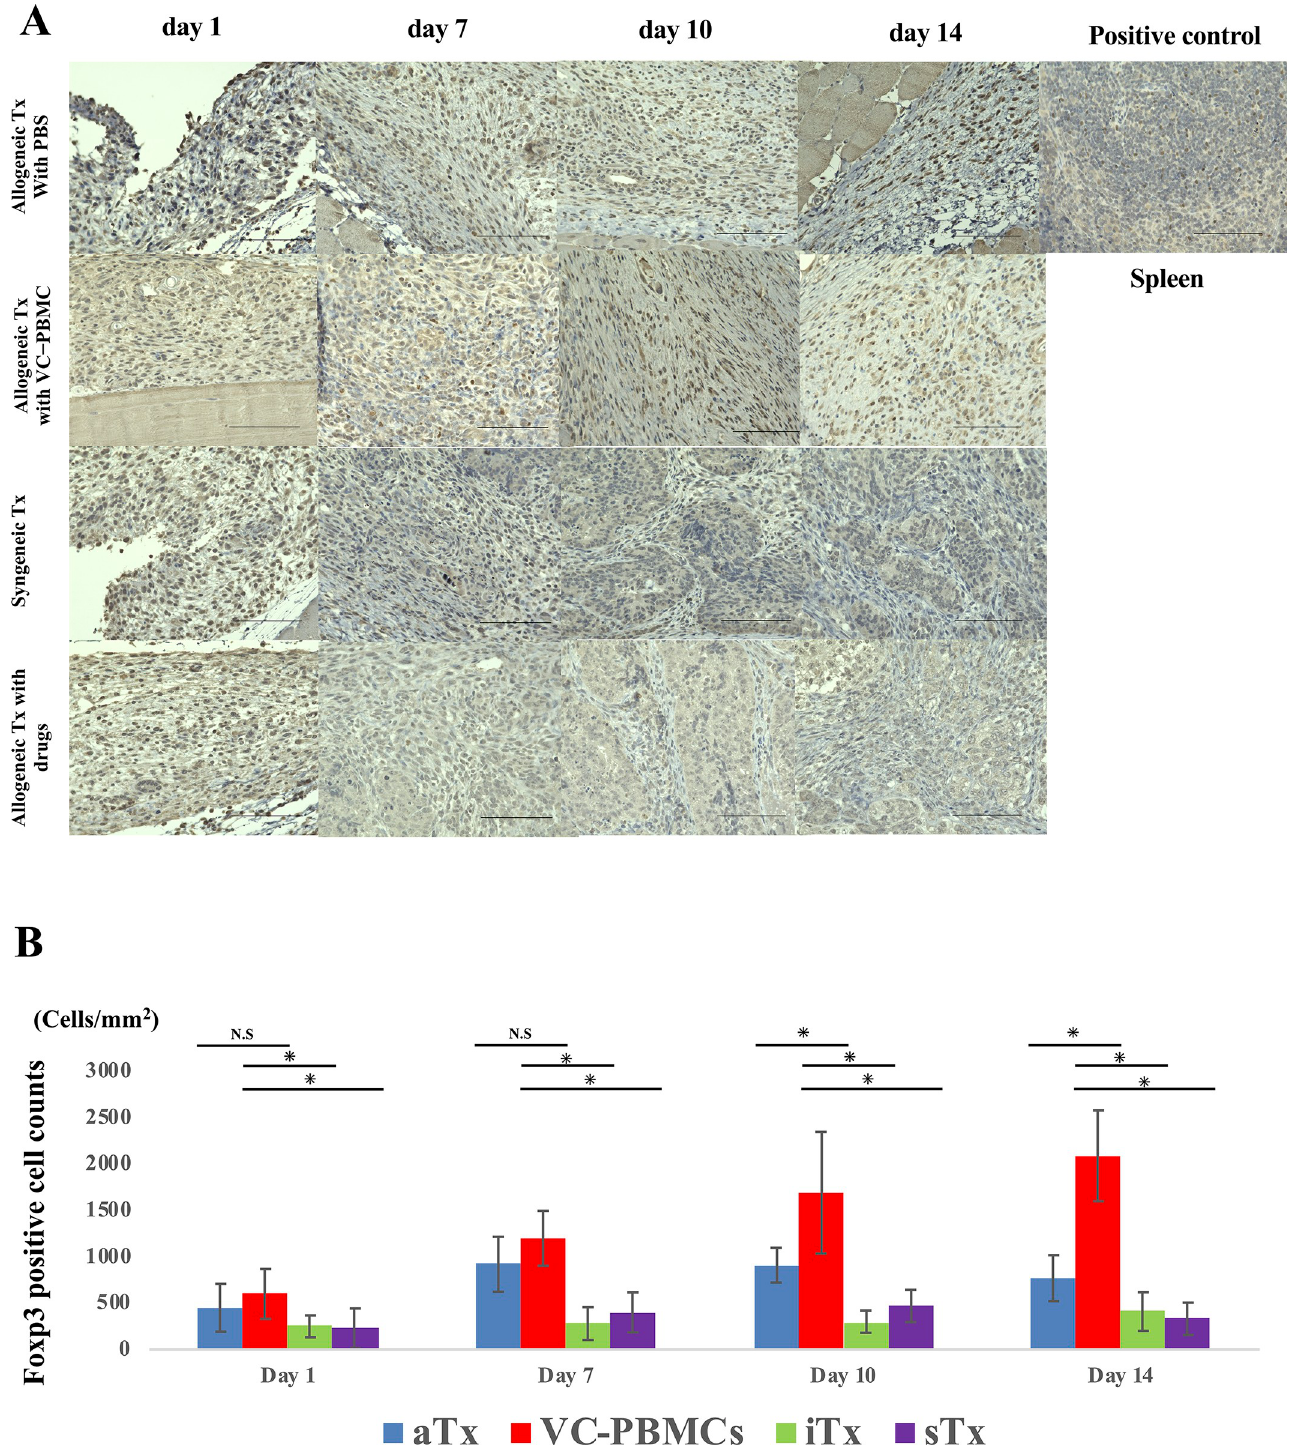
Fig 4. Infiltration of regulatory T cell lymphocytes into the grafts. A , Foxp3 + regulatory T cells into grafts at days 1, 7, 10, and 14, using spleen tissue as positive control. B , Comparison among groups of CD3 + cell counts. Scale bar, 100 μ m. � , P < 0.05; N.S., not significant.